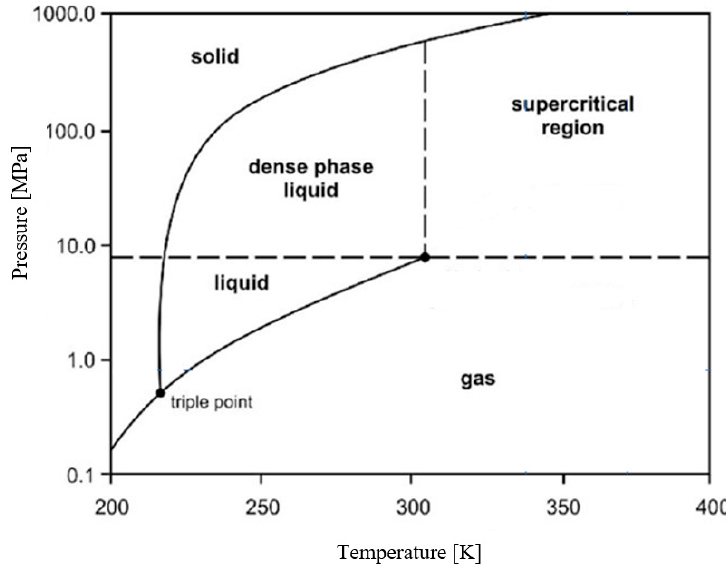
Figure 3. Relationship between phase change of CO 2 and temperature/pressure [132].